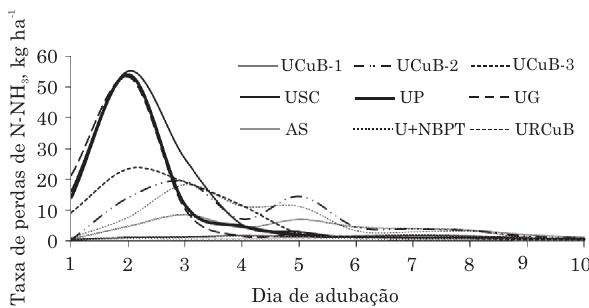
Figura 4. Taxa de perdas de N-NH 3 dos diferentes fertilizantes nitrogenados ao longo do tempo,